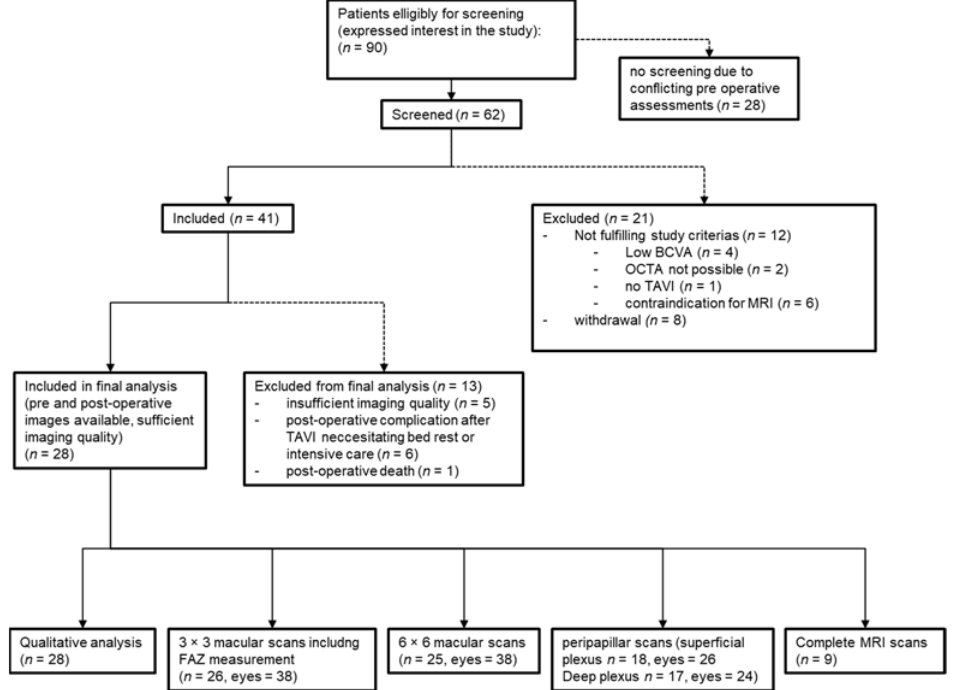
Figure 1. Flowchart of the patient enrollment process of the study cohort. BCVA = best corrected visual acuity. OCTA = optical coherence tomography angiography. TAVI = transcatheter aortic valve implantation. MRI = magnetic resonance imaging. FAZ = foveal avascular zone.